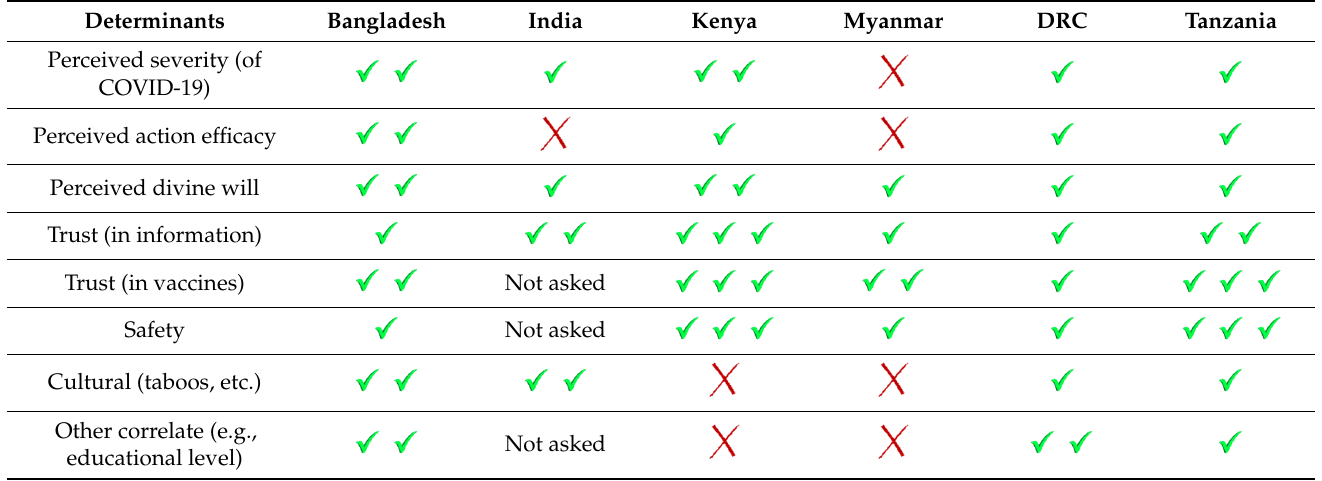
Safety Cultural (taboos, etc.)